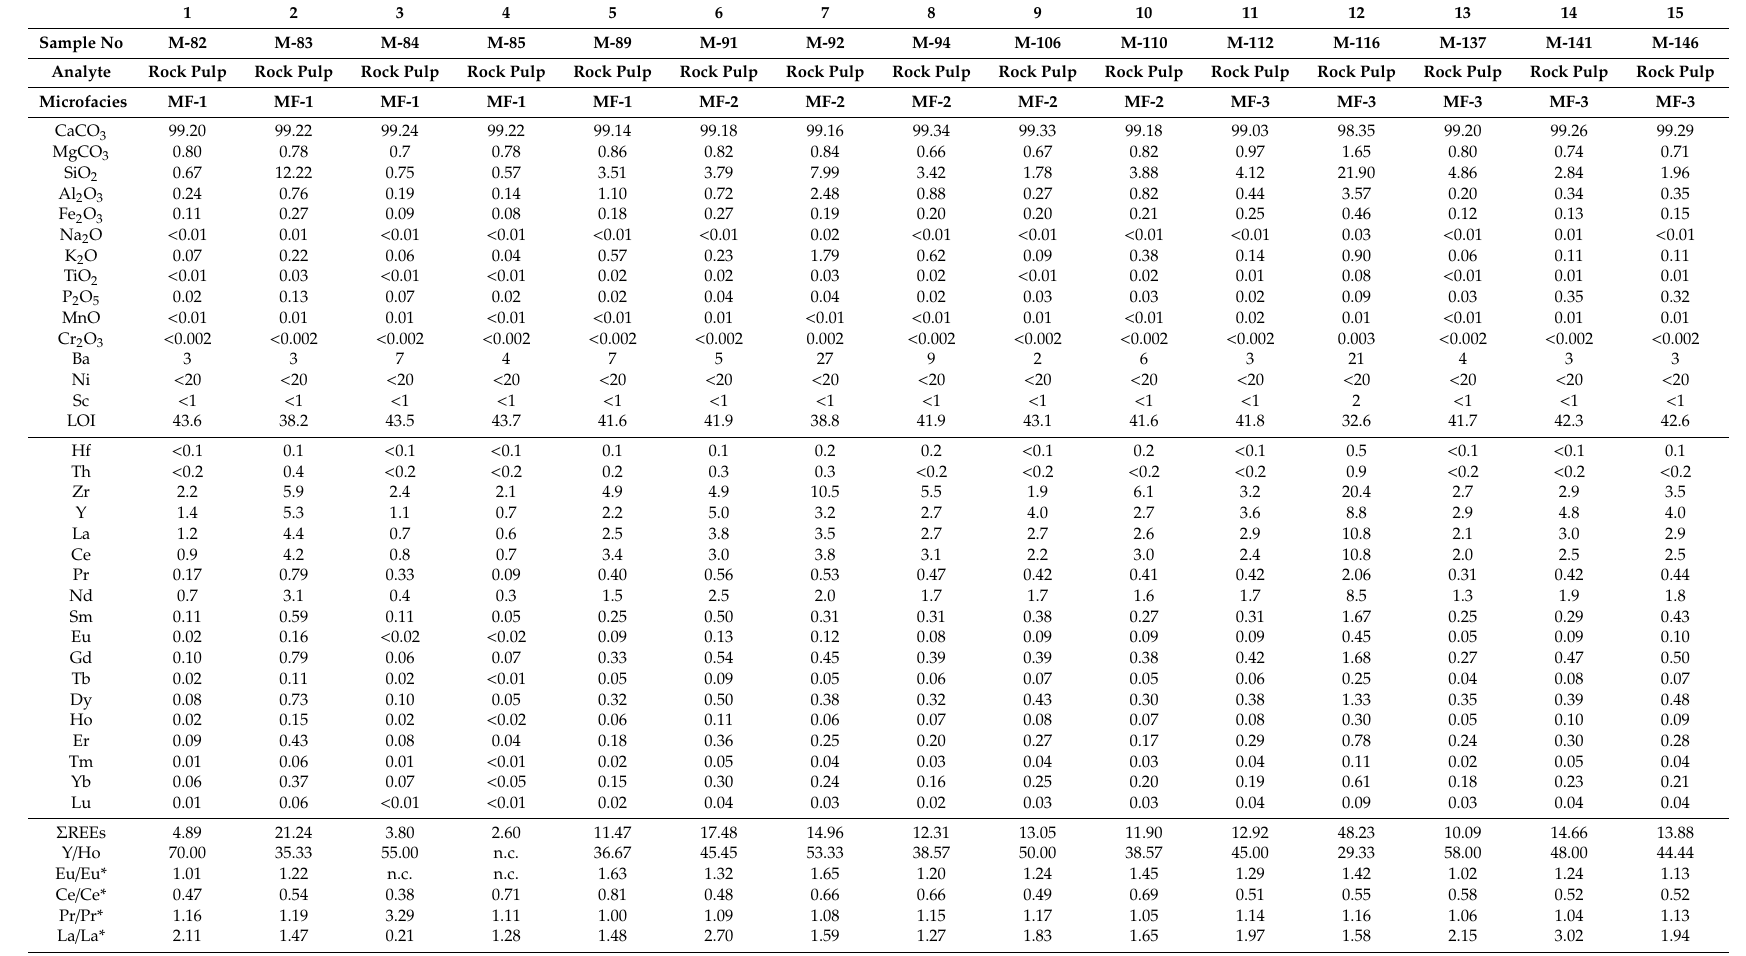
Table 1. Major, trace and rare earth elements of the limestone succession from the Mescitli area (NE